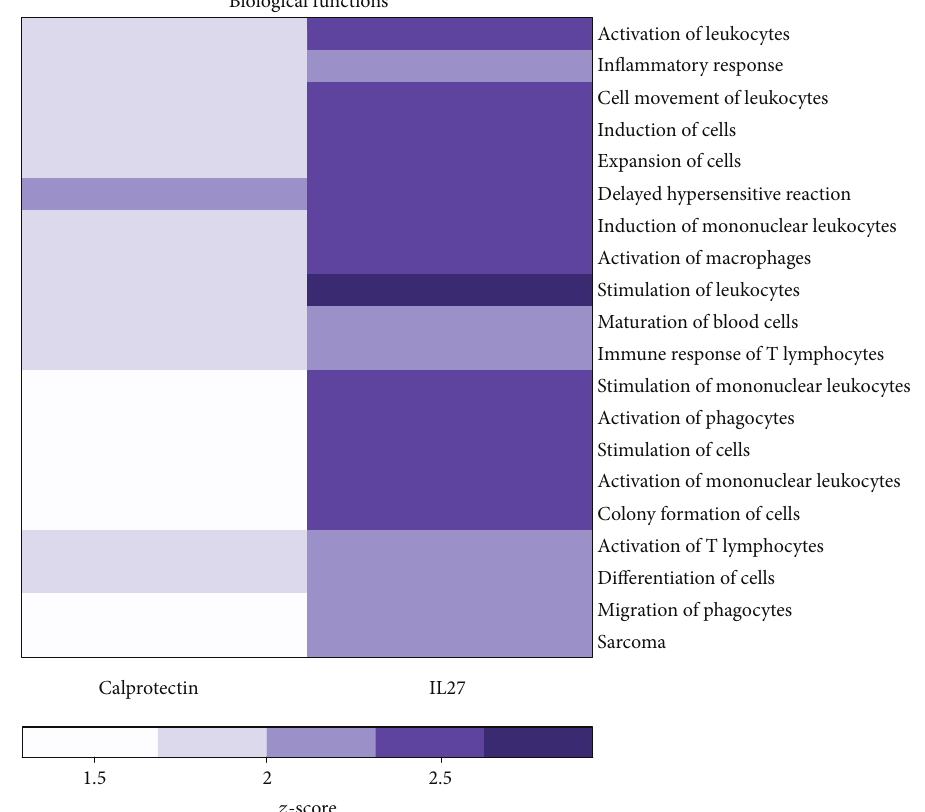
Figure 2: Top 20 biological functions from a comparative gene enrichment analysis of IL27 and calprotectin-mediated gene expression. The biological function gene enrichment analysis was carried out by IPA and represents the 𝑧 -score (activation ≥ 2).